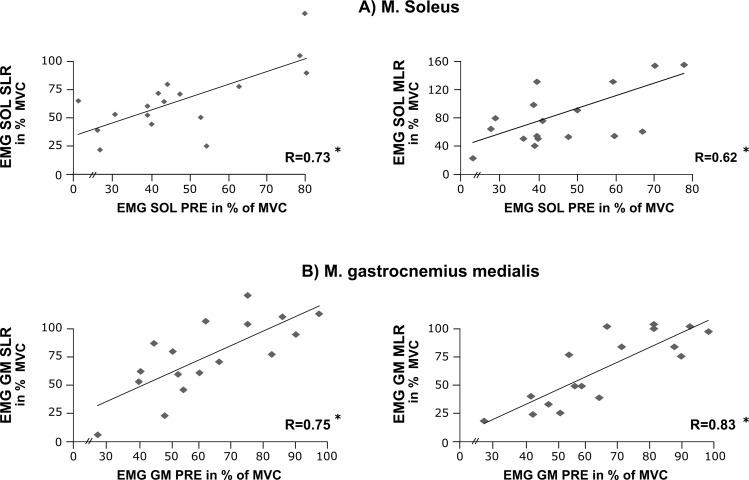
Proactive and reactive bivariate correlations and correlation coefficients of shank muscles.Correlations among the variables of EMG pre-activation (PRE, abscissas), short-latency response (SLR, left) or medium-latency response (MLR, right), respectively, for the shank muscles (A) M. soleus and (B) M. gastrocnemius medialis (ordinate). Results are illustrated for the drop jumps performed in the unknown condition on the hard surface. These findings illustrate the dependency of the dorsiflexors’ activation intensity after touch-known on the muscles’ pre-activity prior to touch-down. * Significant findings (P < 0.05).